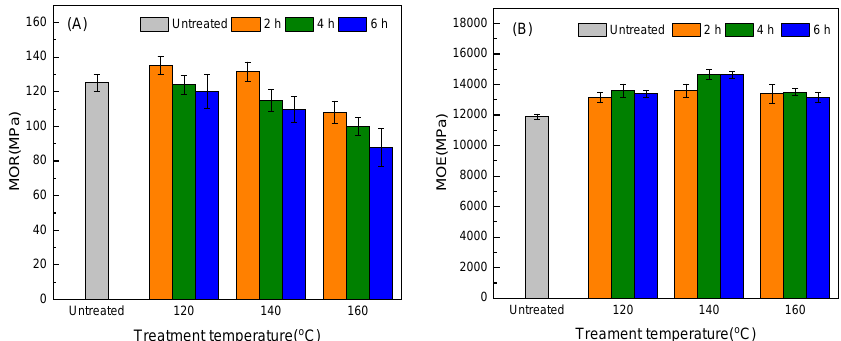
Figure 4. ( A ) The modulus of rupture (MOR) of bamboo scrimber after hot oil treatment; ( B ) the modulus of elasticity (MOE) of bamboo scrimber after hot oil treatment. Error bars represents the standard deviation of the data.